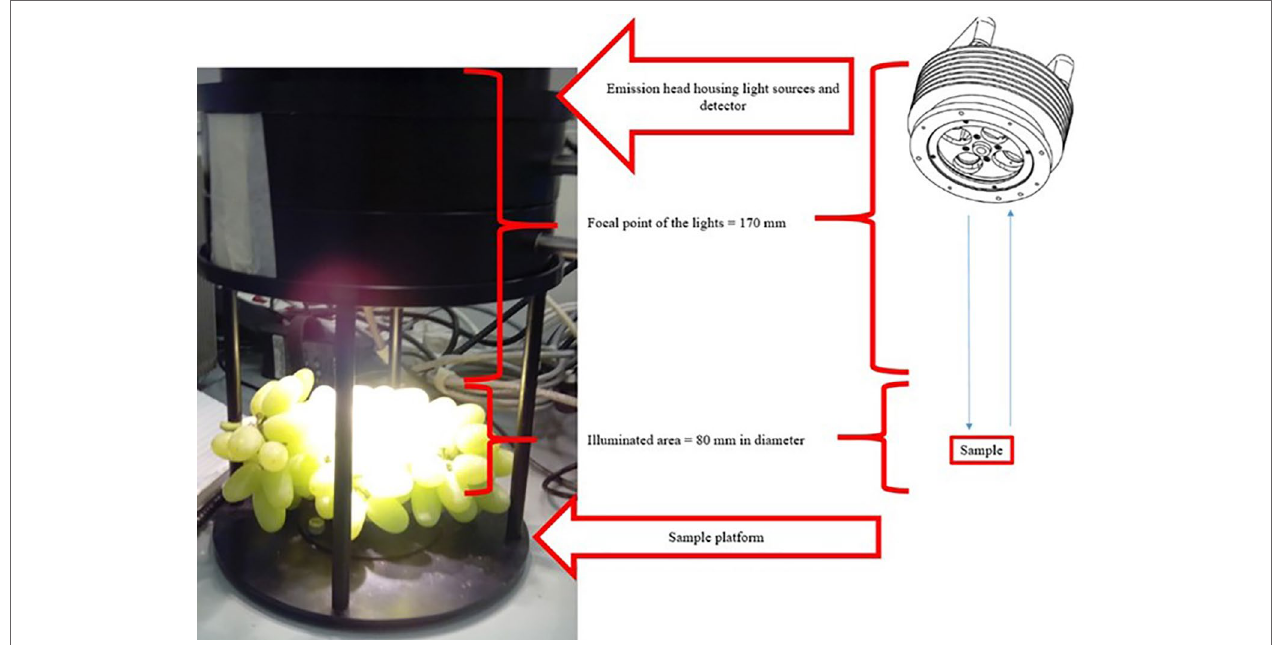
FIGURe 2 | An intact Thompson Seedless table grape bunch scanned contactless with the MATRIX-F NIR spectrometer. Important parts of the instrument are also illustrated.